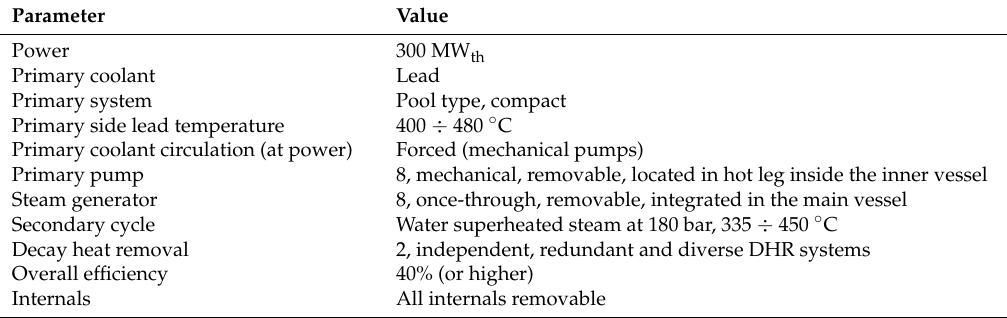
Figure 1. Conceptual configuration of ALFRED. Table 2. ALFRED key parameters [6].